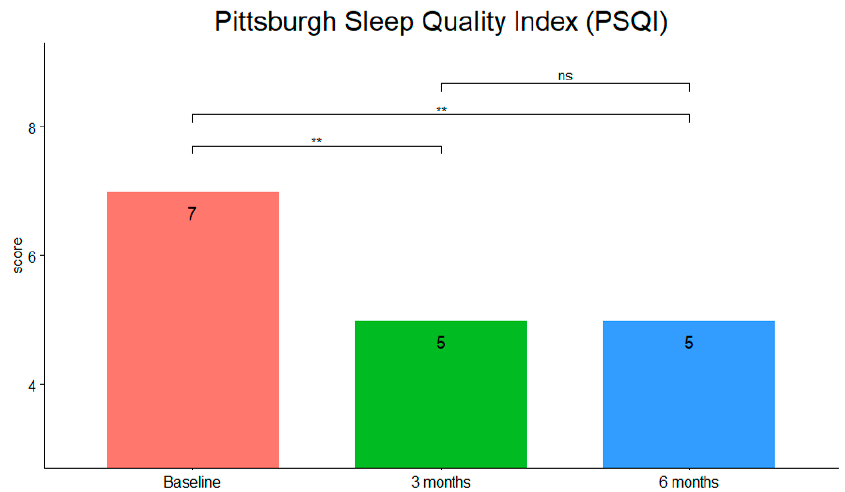
Figure 6. Median scores of PSQI at the three timepoints (**: p -value < 0.01; ns, not